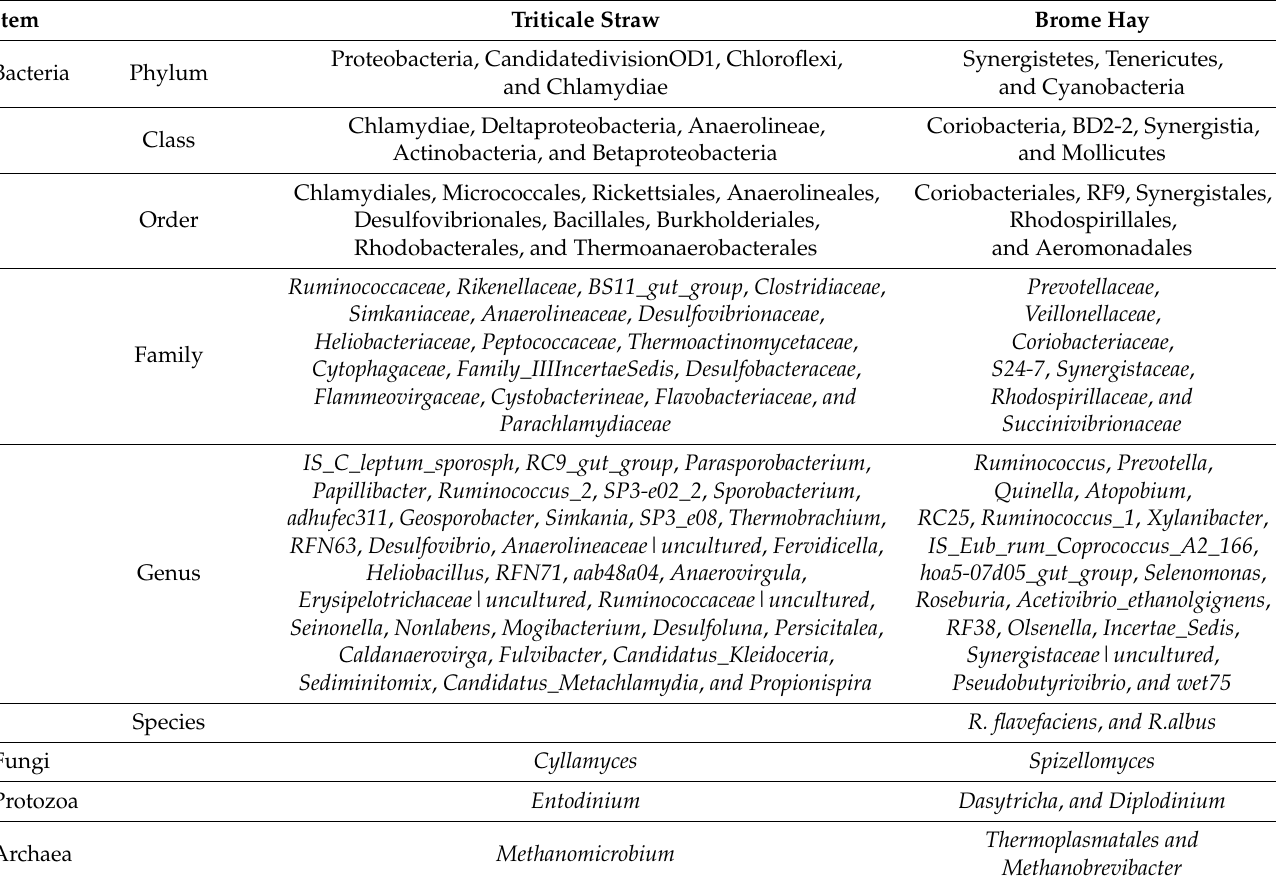
Table 1. The phylotypes selectively enriched by